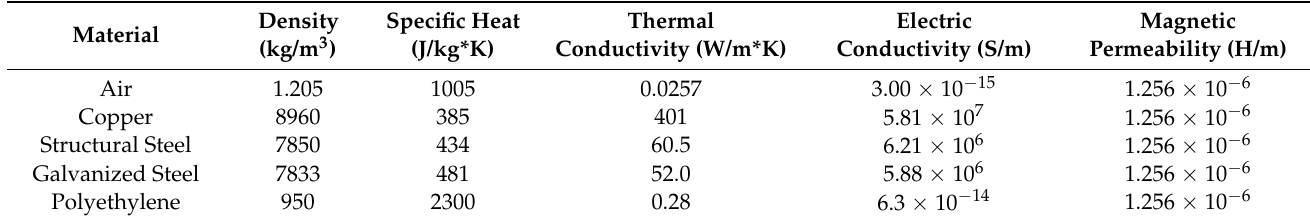
Table 2. Materials properties for electromagnetic and thermal analyses.